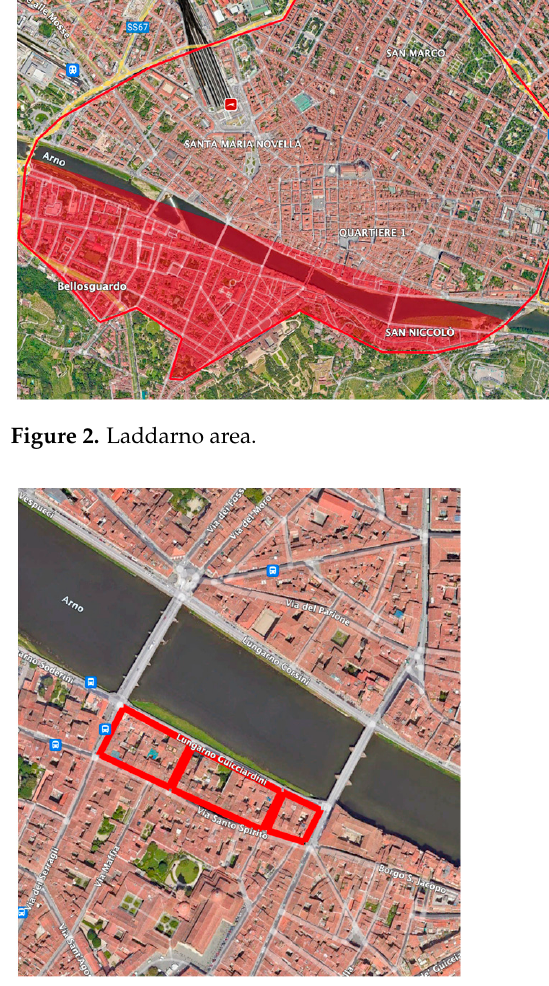
Figure 3. Blocks under investigation.